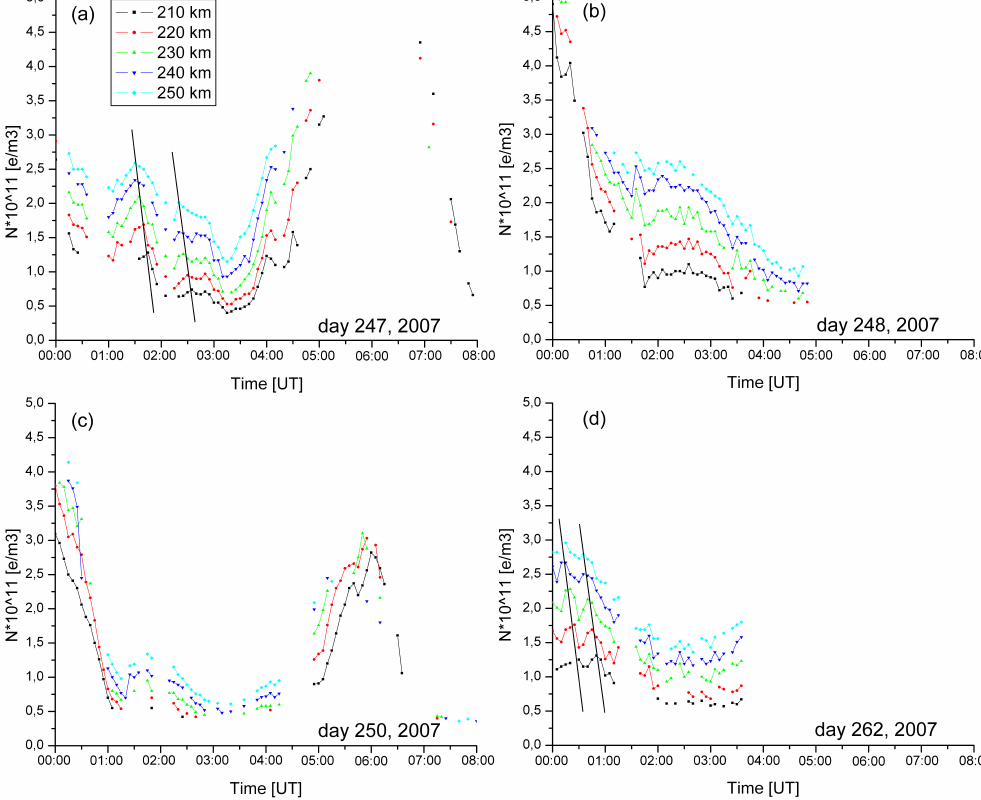
Fig. 3. Electron density variations for real heights 210, 220, 230, 240, and 250km for days (a) 247, (b) 248, (c) 250, and (d) 262, 2007 from 00:00 to 08:00UT (20:00 to 04:00LT). Data gap characterizing (a), (b), and (d) is due to RSF occurrence which avoided the operator digitized the trace.